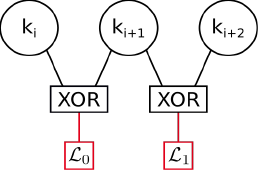
Figure 3: Leakage model with transition / XOR leakage of two